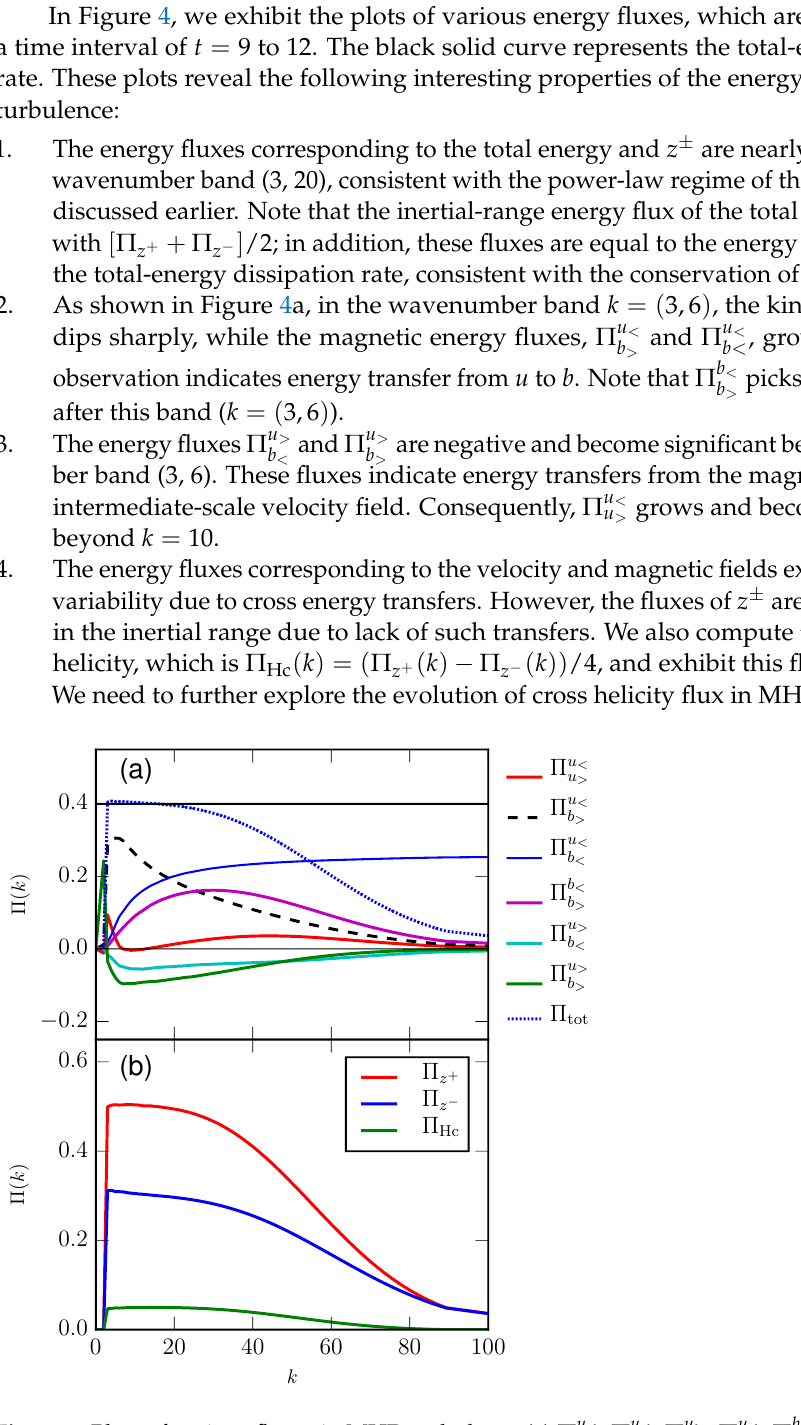
and Π Hc averaged over time frame t = 9 −